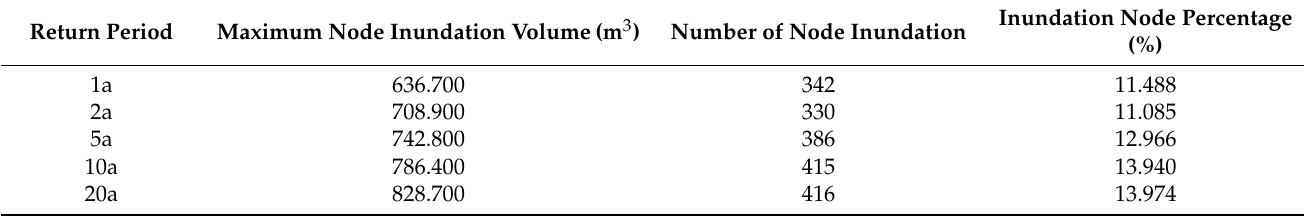
Table 10. The results of inundation node (RCP8.5 relative to RF).